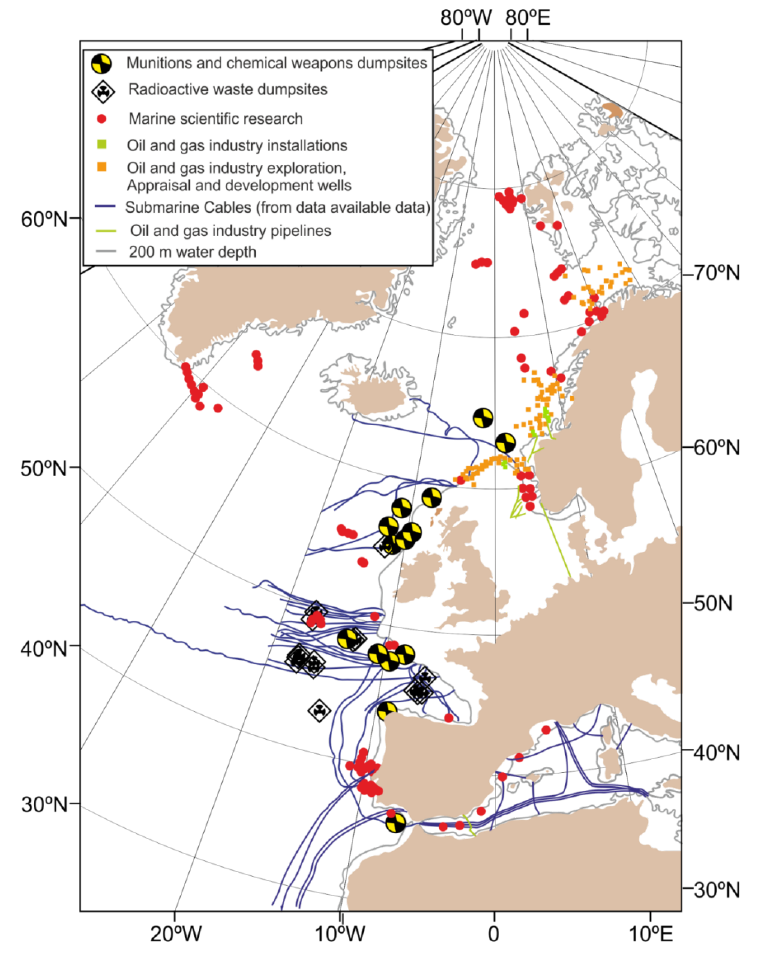
Figure 2. Some of the main human activities in deep-sea areas (>200 m water depth) in the NE Atlantic and western Mediterranean. The figure was used as idea and base to create a new one including more information from [25] .